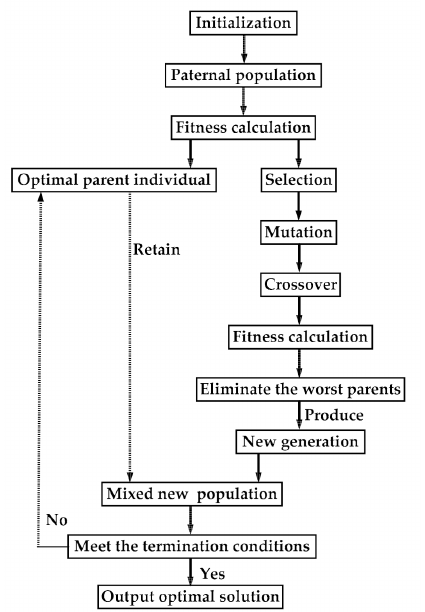
Figure 5. The optimization process of the genetic algorithm (GA).